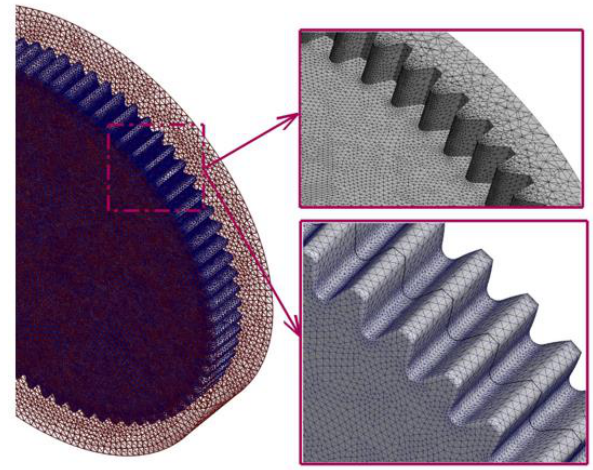
Figure 3. Meshing of computational domain.